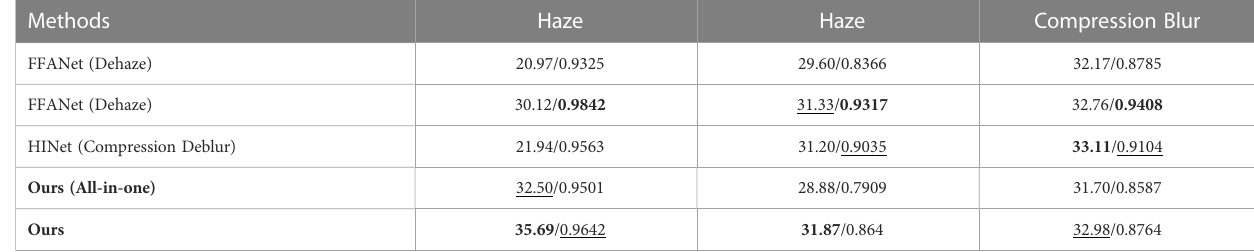
TABLE 3 Quantitative comparison results (PSNR/SSIM) of some excellent methods for dehazy, motion deblurring and compression deblurring tasks. Methods